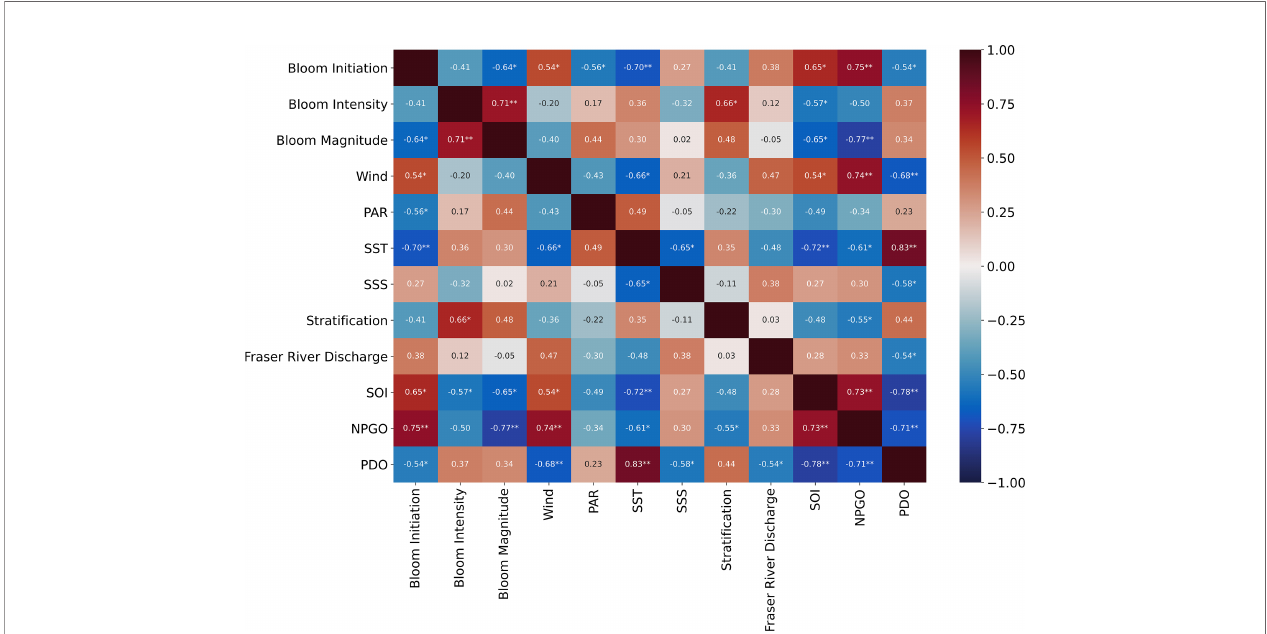
TABLE 2 | Results of linear regressions and the signi fi cance of the models chosen by forward stepwise regression to describe the environmental variables in fl uencing Chl a bloom dynamics. Dependent Variable Independent Variable Coef fi cient SE t-value p